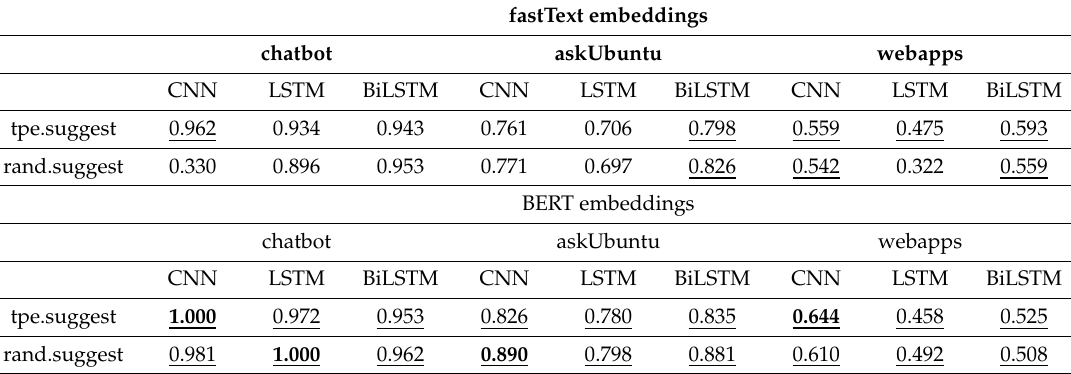
Table 7. Evaluated accuracies on the Latvian testing datasets with optimized models. For the other notation, see Table